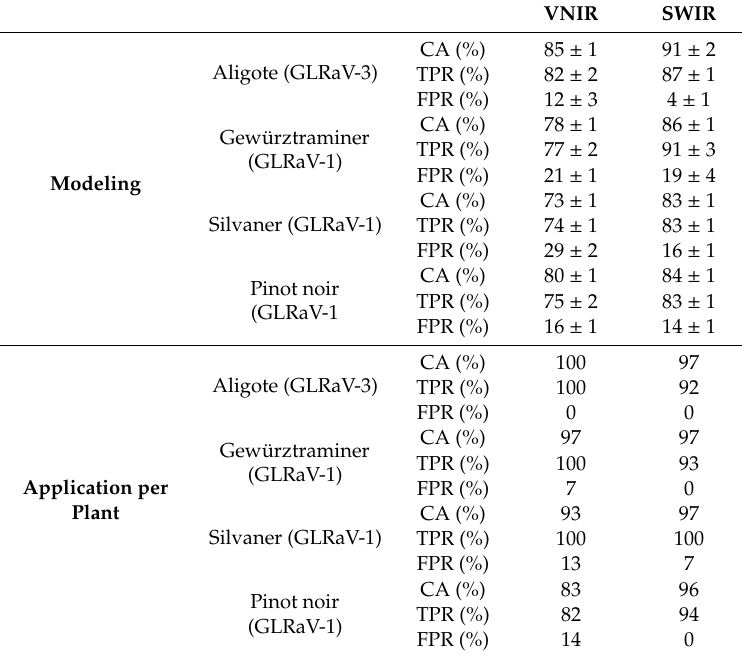
Table 7. Results for the detection of GLRaV-symptomatic greenhouse plants. For modeling, all pixels were evaluated not considering spatial scales. Developed models were then applied per plant using all leaves for majority voting.